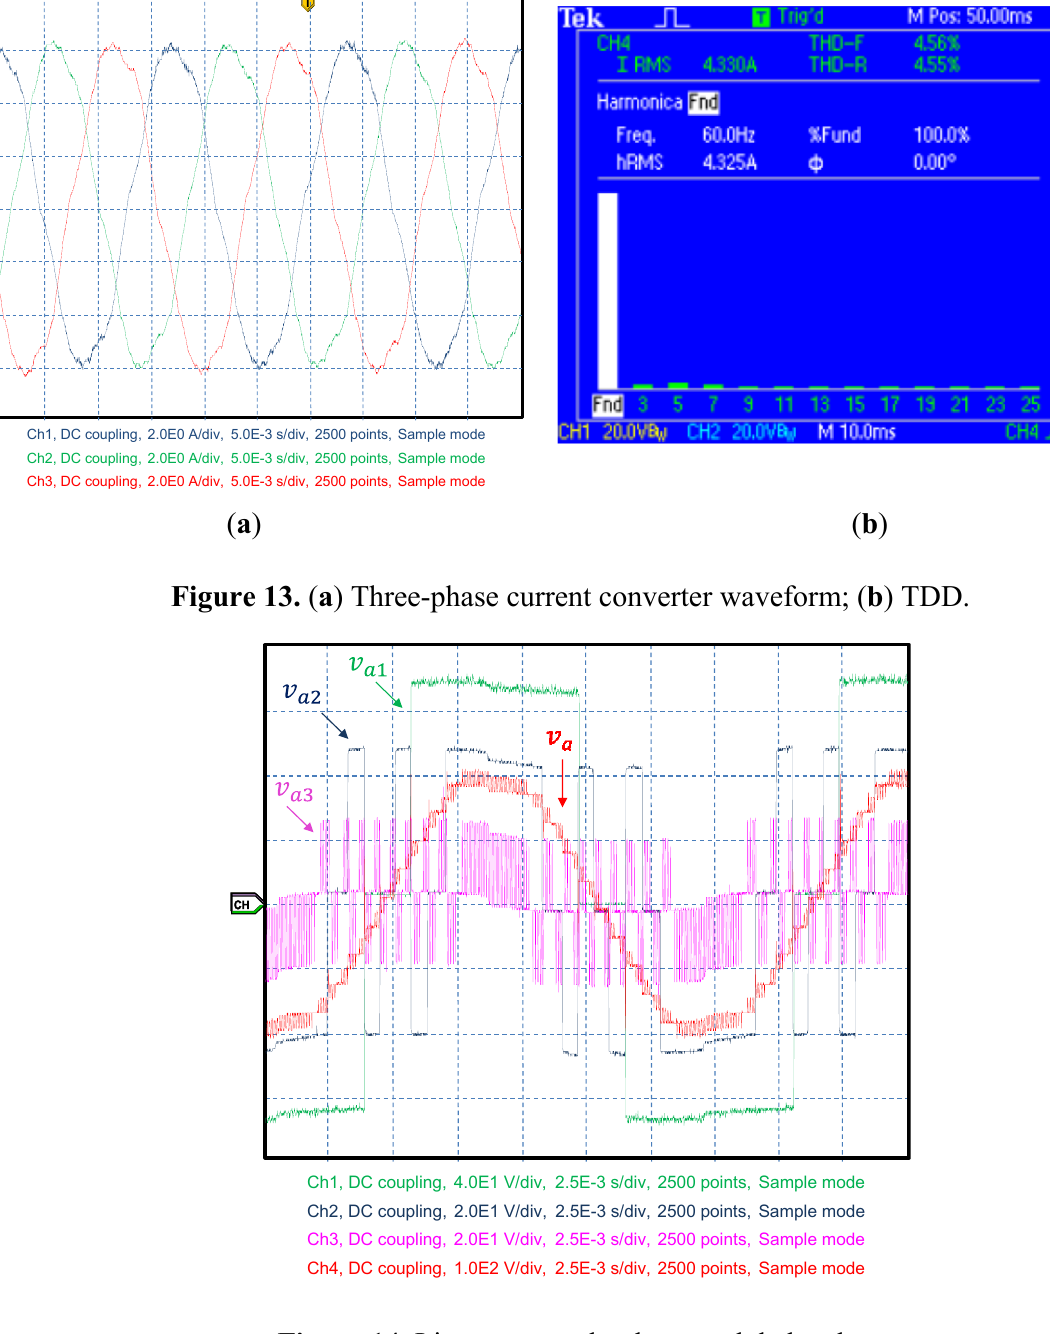
Figure 14. Line-to-neutral voltage and dc